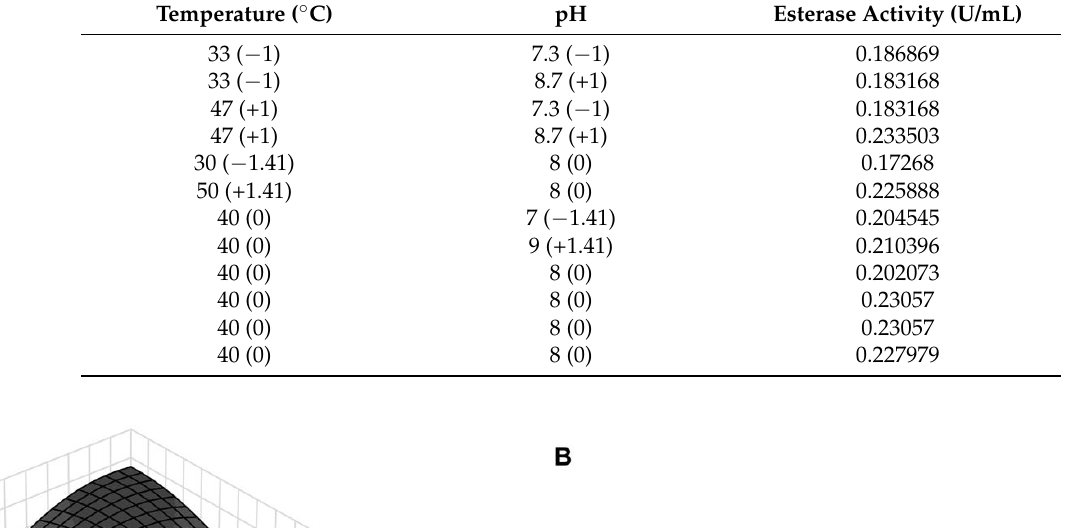
Table 4. Obtained esterase activity values for the conditions analyzed by this experimental design.